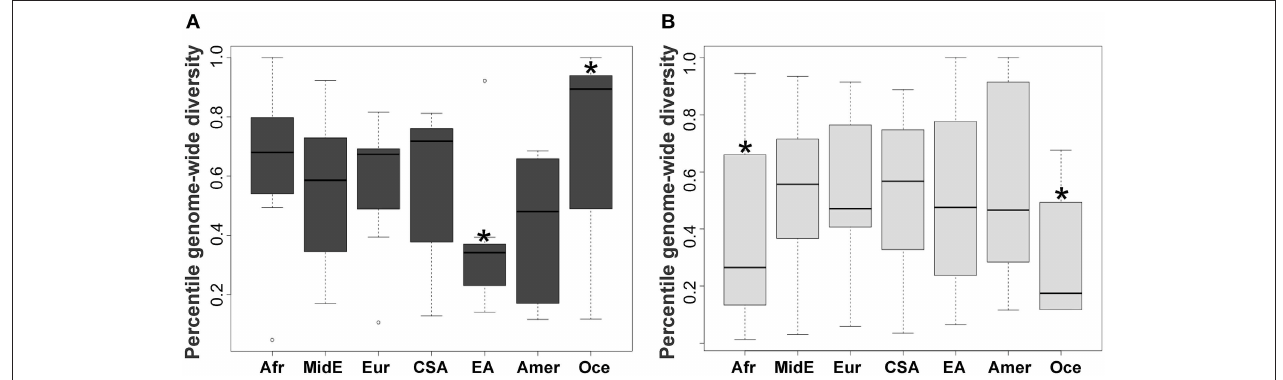
FIGURE 1 | Distinct diversity patterns of centromeric and telomeric KIR regions. (A) Diversity of centromeric KIR SNPs relative to the distribution of genome-wide SNPs. (B) Diversity of telomeric KIR SNPs relative to the distribution of genome-wide SNPs. Horizontal bar represents mean. Asterisks mark statistical significance ( p = 0.01) for Kolmogorov–Smirnov test. Afr, Africa; MidE, Middle East; Eur, Europe; CSA, Central and South Asia; EA, East Asia; Amer, America; Oce,